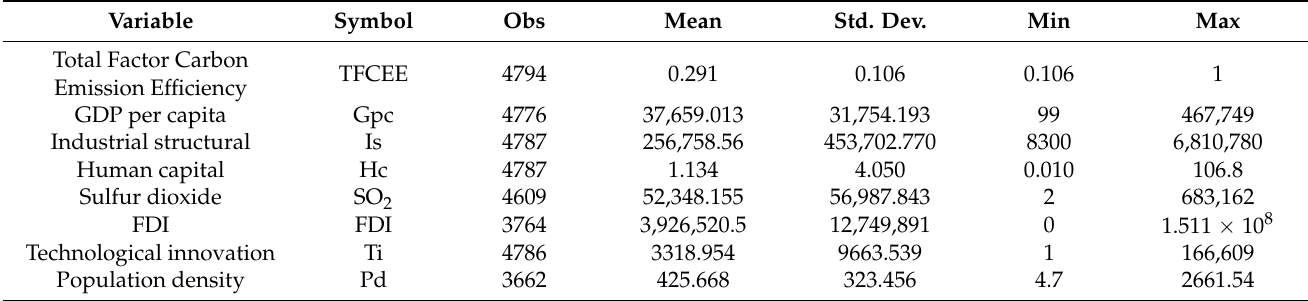
Table 3. Descriptive Statistics.